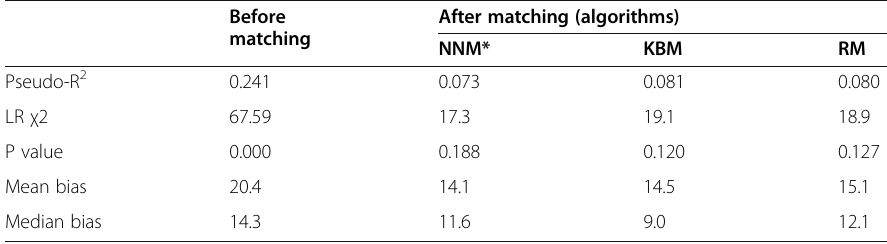
Table 7 Matching quality test: balancing property